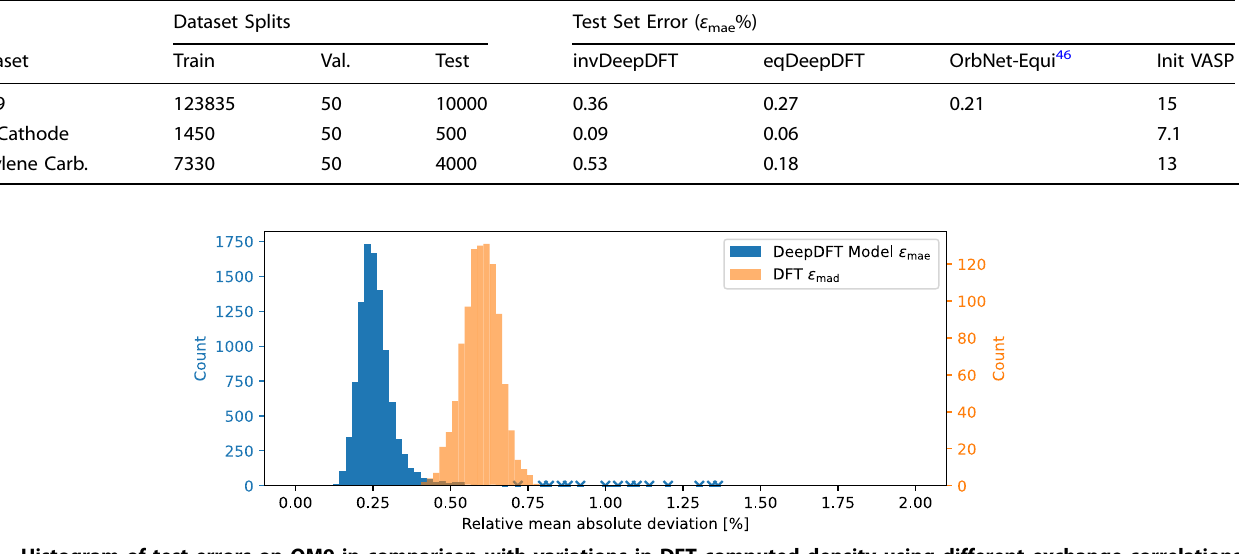
Fig. 2 Histogram of test errors on QM9 in comparison with variations in DFT computed density using different exchange correlations functional. The markers show bins with a count of